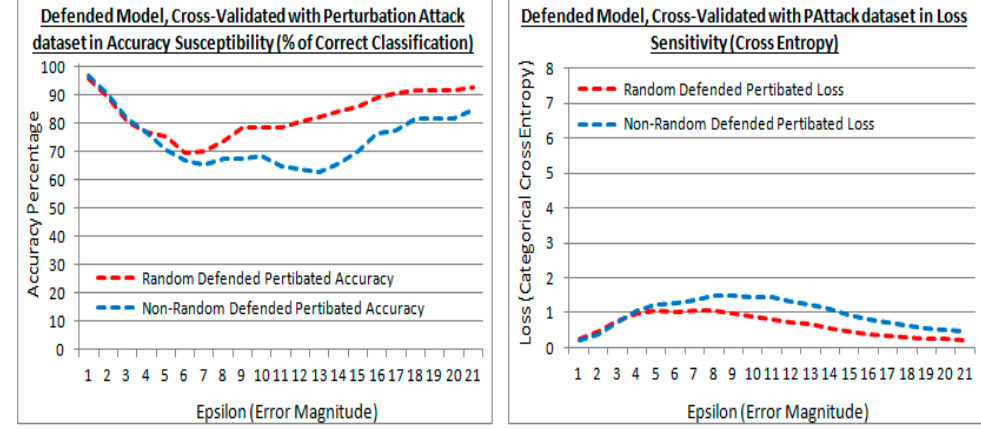
Figure 13. Accuracy and losses of a defended model with epsilon increments against the validation attack dataset, for both the existing (random) and proposed (non-random) methods.